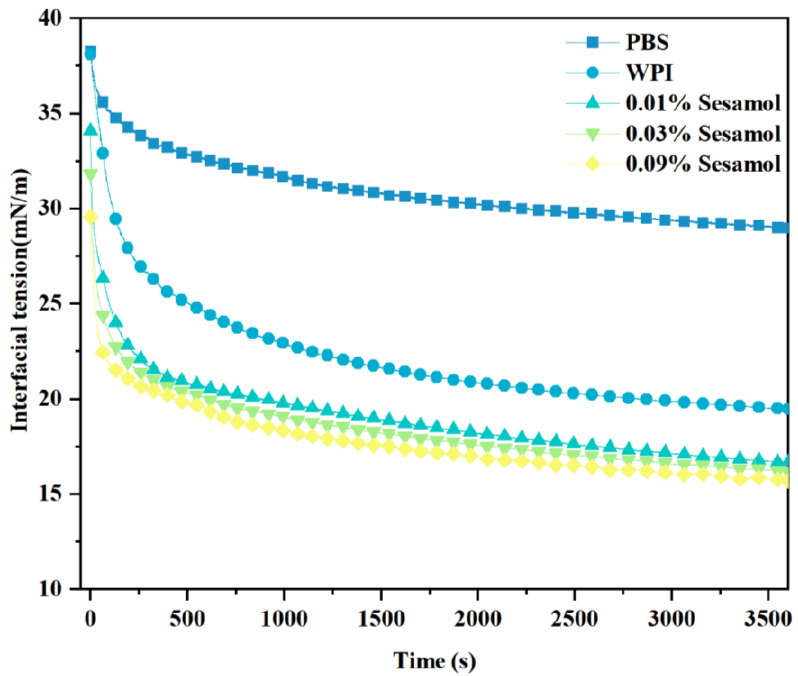
Figure 7. Effect of sesamol on the interfacial tension between the oil phase and WPI solution with time.